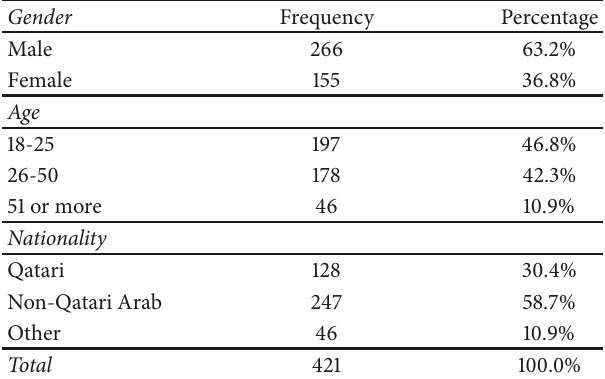
Table 1: Characteristics of the